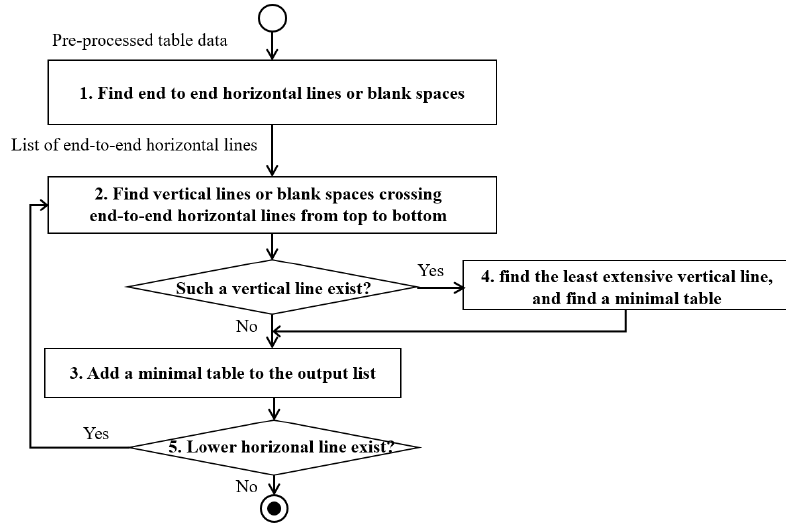
Figure 4. Five steps to find minimal tables.